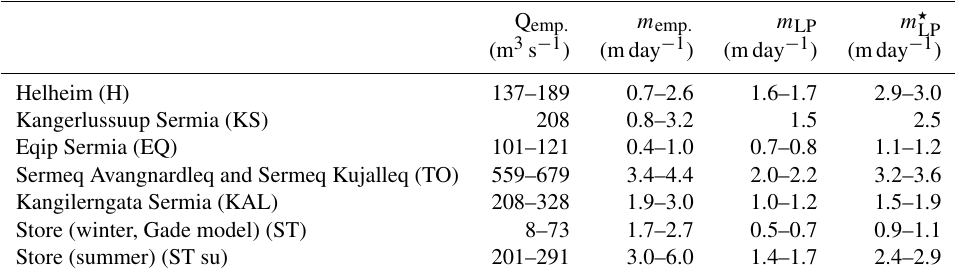
Table 6. Estimated subglacial discharge Q emp and melt rate m emp for a number of glaciers and corresponding melt rate m lp from LP model simulations. Values of Store winter are taken from the Gade model (Fig. 15). For each glacier, local hydrography (temperature and salinity profiles) and measured subglacial discharge is used to drive the LP model. Ranges indicate measurement errors. Errors in subglacial discharge are propagated to errors in simulated melt rate via the LP model. For the Store Glacier in winter we only report a representative value in the table, where both mean and error were averaged. Simulated melt rate m LP is obtained with E 0 = 0 . 036, (cid:48) T = 2 . 2 × 10 − 2 . Melt rate m (cid:63) LP with modified (cid:48) T = 4 . 2 × 10 − 2 is also provided. Q emp